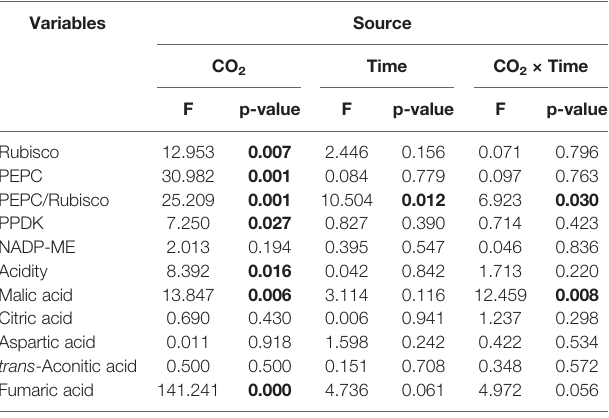
TABLE 4 | Two-way ANOVA results for physiological parameters in O. cordata , with CO 2 concentration and time as